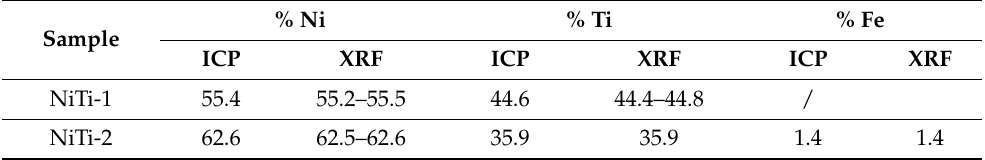
Table 1. Chemical composition of the NiTi-1 and NiTi-2 samples.